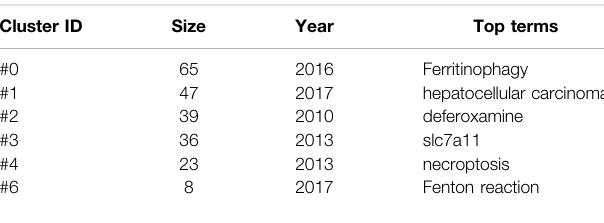
TABLE 6 | Top 10 largest clusters of co-cited references related to ferroptosis in cancer research. Cluster